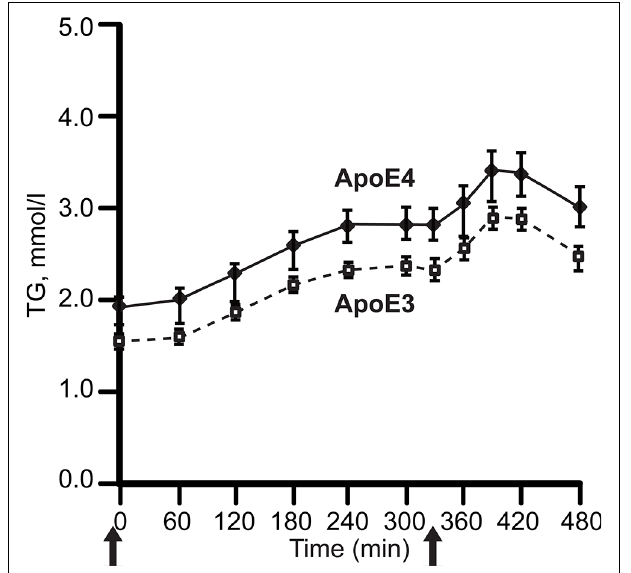
FIGURE 3 | APOE alleles and post-prandial plasma triglyceride levels (TG). Plasma was sampled after two meals in healthy adults, ages 20–70 years. with BMI 19–32 kg/m 2 ; APOE3 homozygotes, N = 142; APOE3/4 heterozygotes, N = 65. After fasting overnight, subjects received breakfast (49 g fat, t = 0) and lunch (29 g fat, 330 min), solid arrows. The APOE4 excess of plasma TG did not differ by age. For clarity, the graph omits APOE2 carriers, whose triglycerides was close to APOE4 . Redrawn and simplified from Carvalho-Wells et al. (2012).